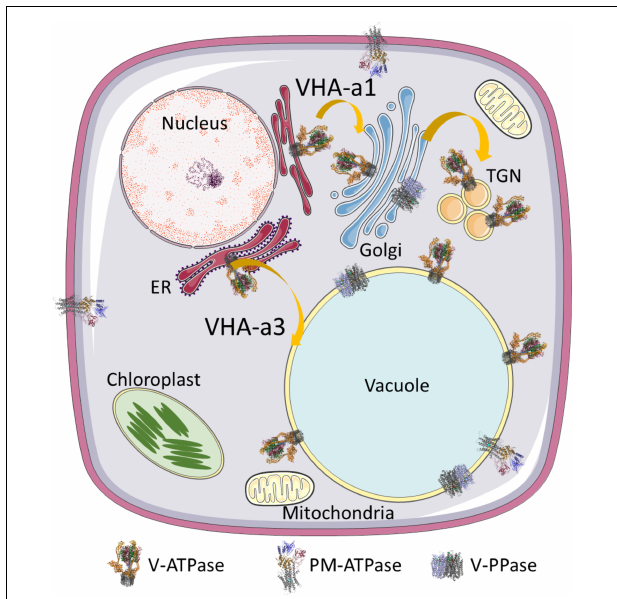
FIGURE 1 | Localization of proton pumps. V-ATPase is present in all endomembranes of the secretory pathway, including ER membranes. V-PPases are localized in the vacuole and rarely in the Golgi, while PM-ATPases are present in the plasma membrane and, in some tissues, even in tonoplasts. Two transport routes exist for V-ATPases. Proton pumps destined for TGN/EE bear VHA-a1 and travel along the secretory pathway, while VHA-a3-bearing pumps are destined for the vacuole and take a direct route from the ER to the vacuole. The structure of V-PPase relies on pdb file 6afs and that of the plasma membrane on file 5 ksd (Croll and Andersen, 2016; Tsai et al., 2019). The structure of V-ATPase is based on pdb 3j9t (Zhao et al.,